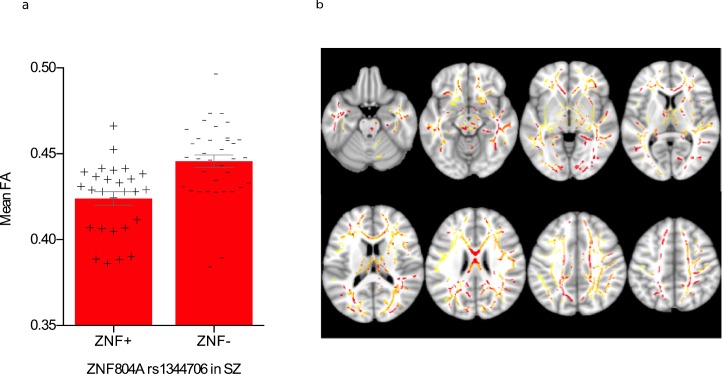
Effect of rs1344706 genotype on fractional anisotropy in schizophrenia.(A) FA was significantly higher in ZNF+ group of SZ patients compared to the ZNF− group of SZ patients (p < 0.05, TFCE corrected) with a post-hoc large effect size given by a Cohen’s d of 1.01, i.e. a difference of one standard deviation between genotype groups, in the largest cluster (51,260 voxels). (B) Areas where FA was significantly lower in ZNF+ compared to ZNF− irrespective of diagnosis (i.e. main effect of genotype, plotted in Fig. 1B) are shown here in yellow. Areas where FA was significantly lower in ZNF+ compared to ZNF− in SZ alone, are shown in red. The overlapping areas where both these effects are significant are shown in orange.